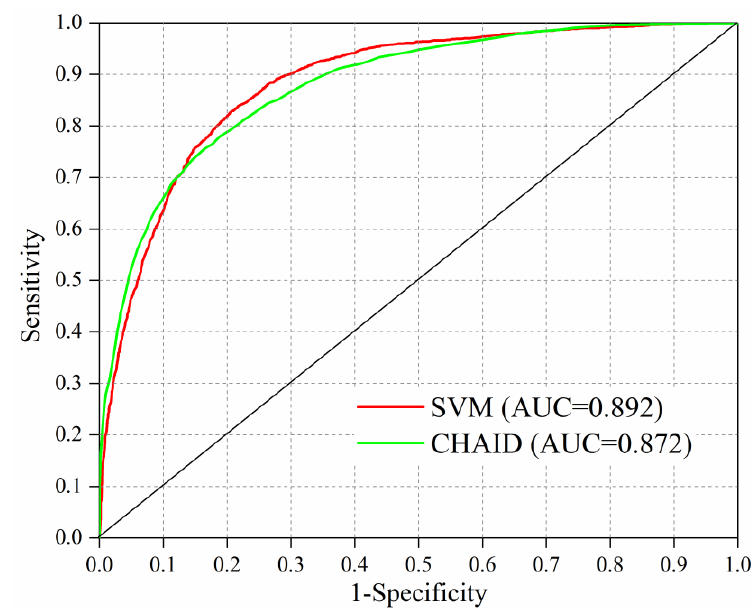
Figure 6. Receiver operating characteristics (ROC) curves of the supervised machine learning (SML) method.